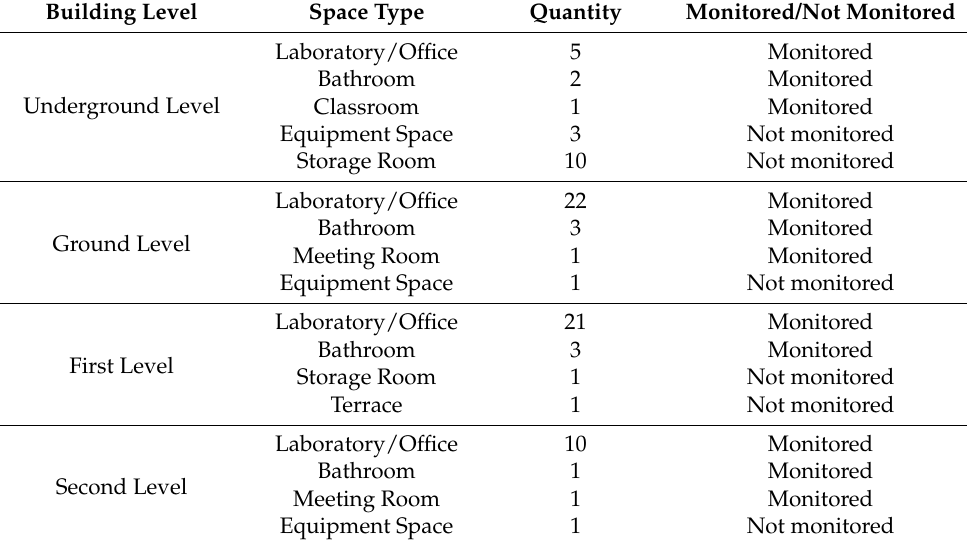
Table 3. Type and quantity of rooms and necessity to be